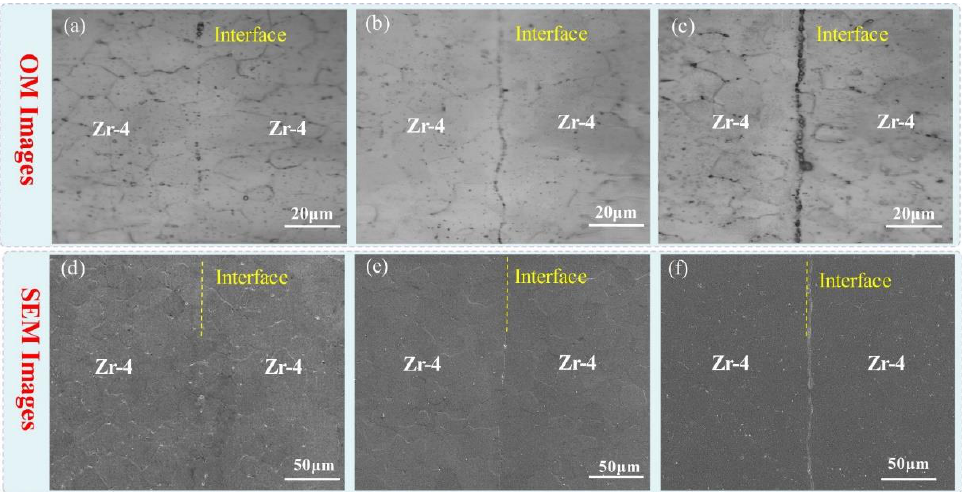
Figure 5. The microscopic metallographic and SEM images of the joints diffusion bonded at 800 °C/7 MPa: ( a , d ) 30 min, ( b , e ) 60 min, and ( c , f ) 90 min.